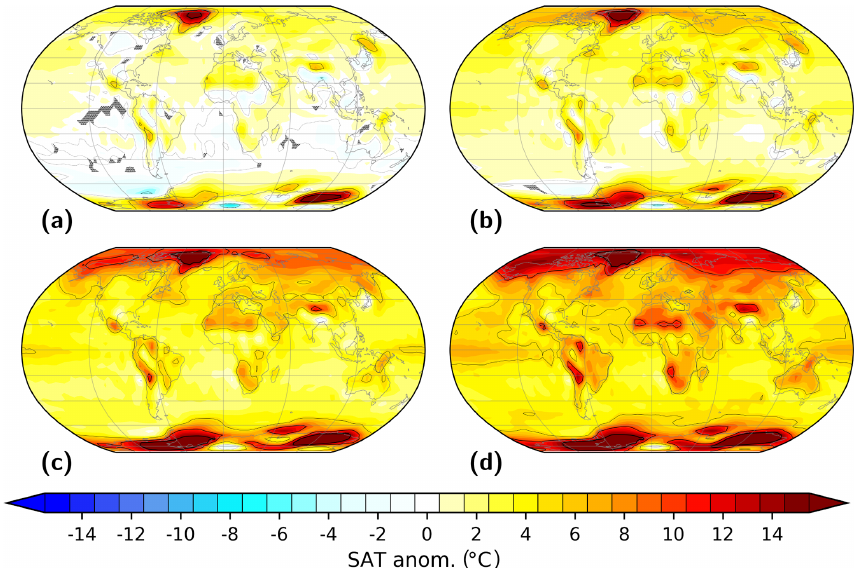
Figure 10. Sensitivity of annual mean surface air temperature (SAT) to variations in the volume mixing ratio of carbon dioxide (CO 2 ) for mid-Pliocene paleogeography. Shown are anomalies with respect to pre-industrial (E280) for simulations (a) Eoi280, (b) Eoi350, (c) Eoi450, and (d) Eoi560. In hatched regions the anomaly is insignificant at the 95% confidence interval based on a t test. Contours illustrate isotherms of − 5 ◦ C (dashed, thin), 0 ◦ C (dotted, thin), 5 ◦ C (solid, thin), 10 ◦ C (solid), and 15 ◦ C (solid, thick). We define SAT as the temperature at a height of 2m above the